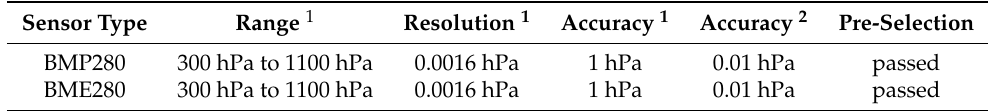
Table 4. Pre-selection of atmospheric pressure sensors.